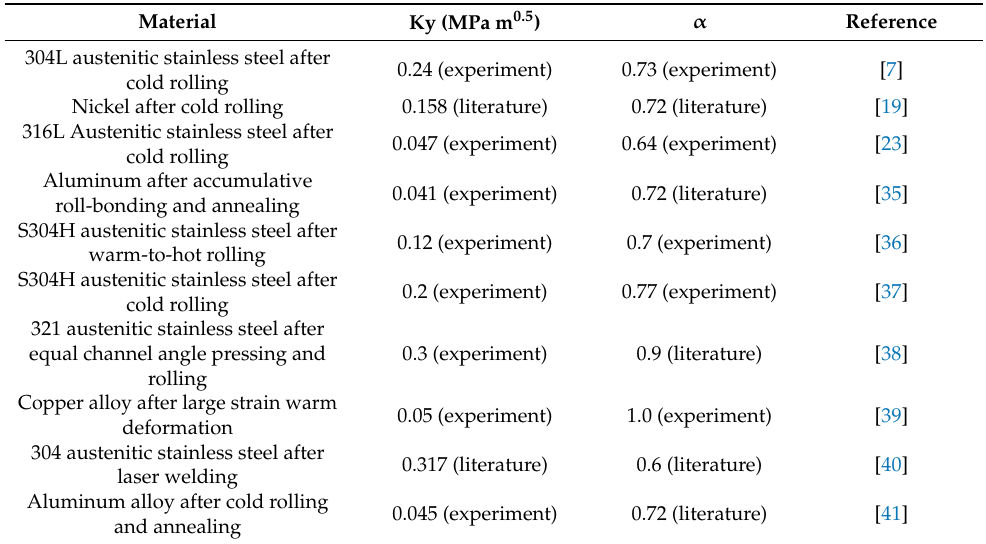
Figure 9. Relationship between the strength increment ( σ 0.2 − σ 0 ), the grain size ( D ) and dislocation density ( ρ ) strengthening in a 316L-type stainless steel processed by cold or warm rolling and subsequent annealing. Table 2. The strengthening factors, Ky and α , for ultrafine-grained (UFG) austenitic steels and some fcc-alloys subjected to large strain deformation.